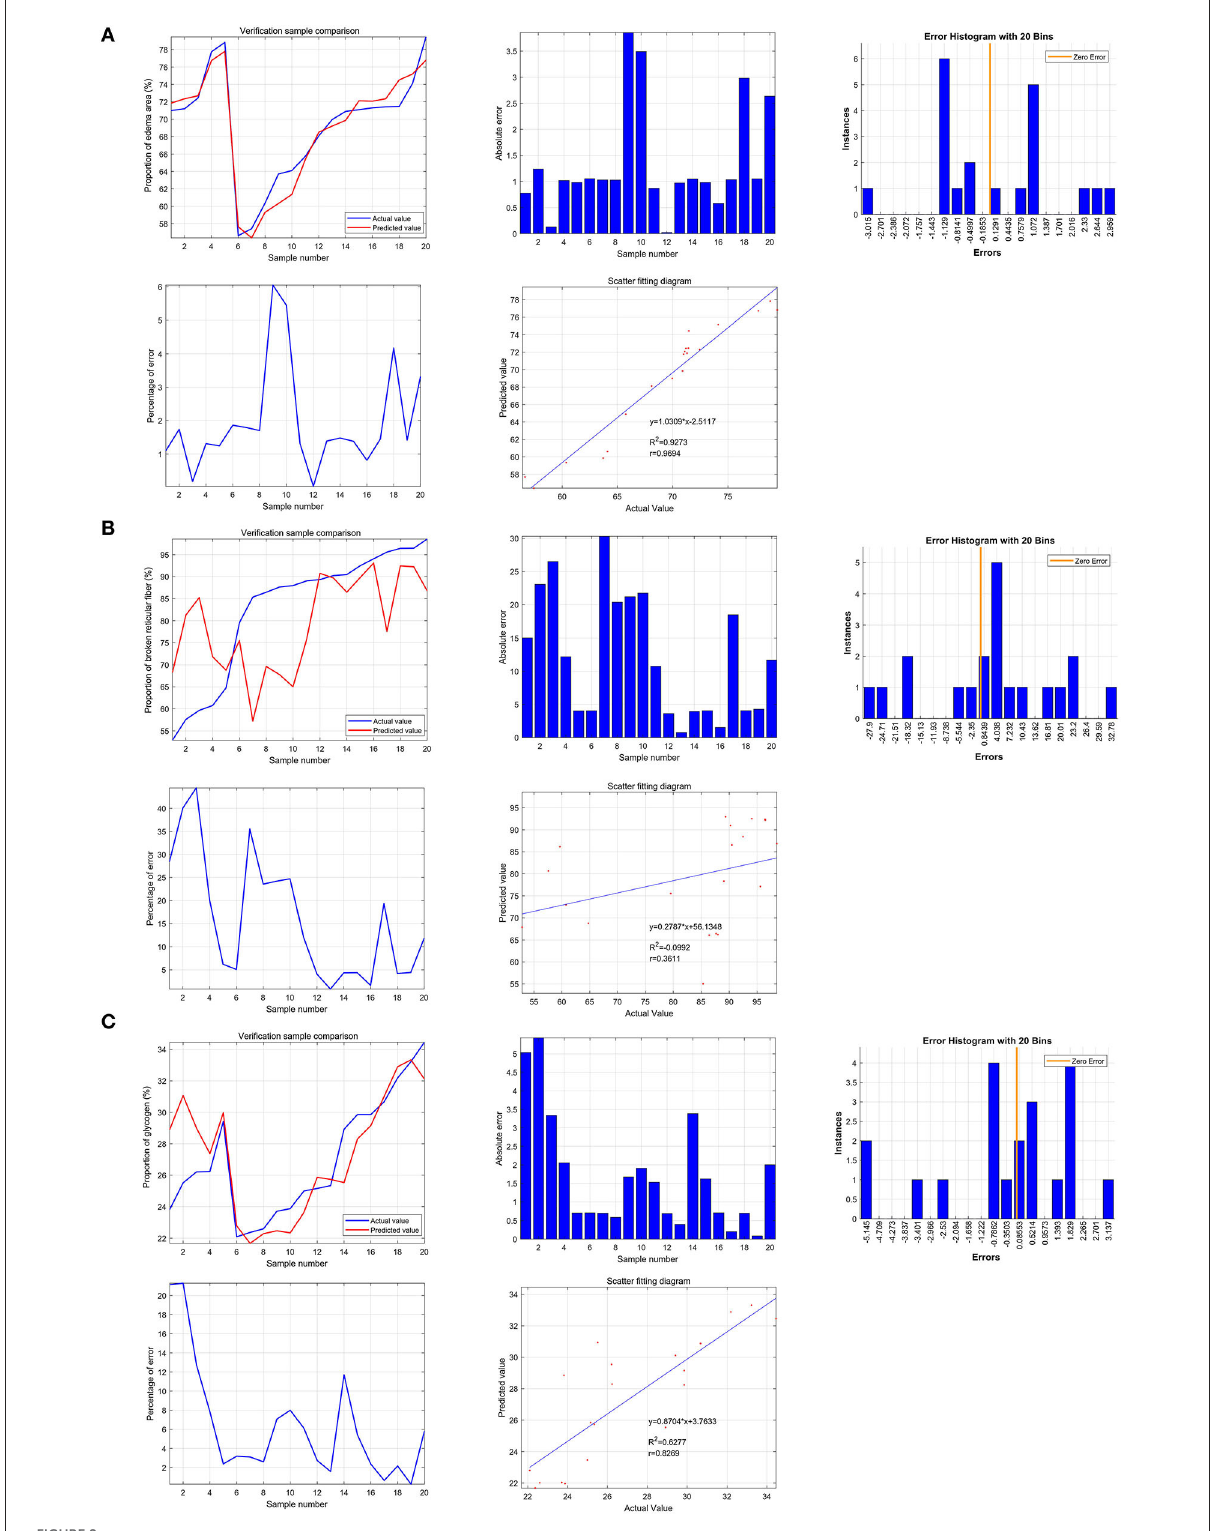
FIGURE8 Predictive value of SGLT1 and SGLT2 for edema, reticular fibers, and glycogen content in the kidney via the support vector machine (SVM). (A) Predictive value of SGLT1 and SGLT2 for the renal edema was 0.9694 ( y = 1.0309*x − 2.5117), and the mean of error was 1.28%. (B) Predictive value of SGLT1 and SGLT2 for broken reticular fibers was 0.3611 ( y = 0.2787*x + 56.1348), and the mean of error was 11.62%. (C) Predictive value of SGLT1 and SGLT2 for the glycogen content was 0.8269 ( y = 0.8704*x + 3.7633), and the mean of error was